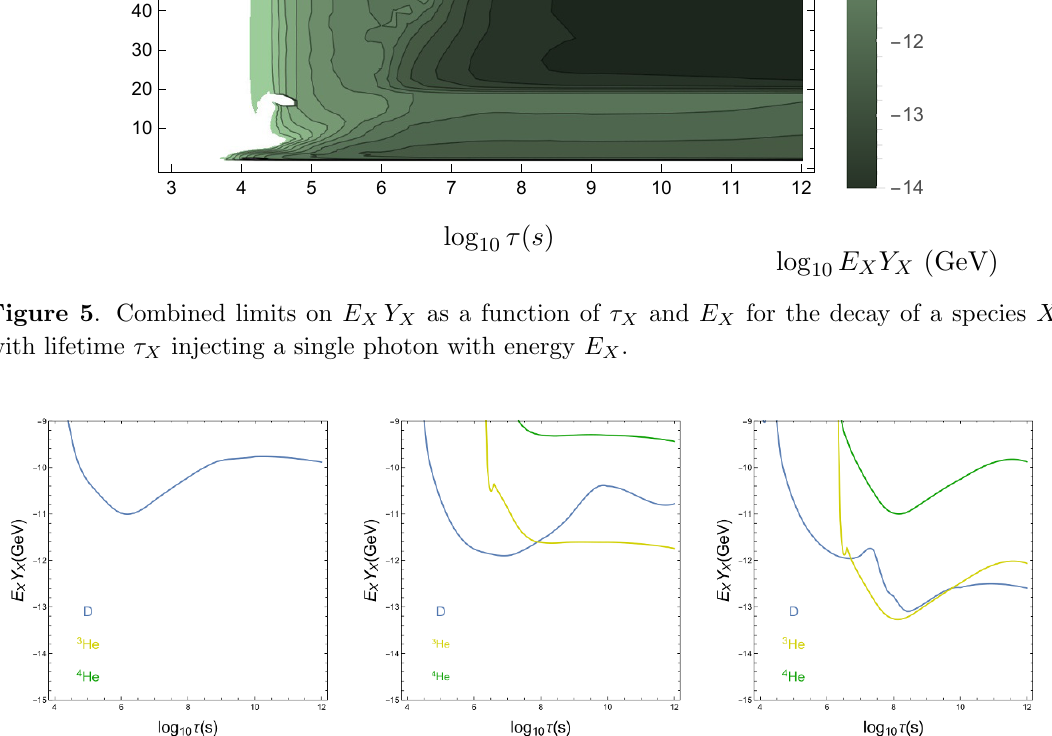
+ e Figure 6 . Limits on E (cid:0) decay of species X as a function X Y X from BBN on the monochromatic e of the lifetime (cid:28) X for individual electron injection energies E X = 10 MeV (left), 30 MeV (middle), and 100 MeV (right). Bounds are given for the e(cid:11)ects on the nuclear species D, 3 He, and 4 He, and contributions to the electromagnetic cascades from FSR are